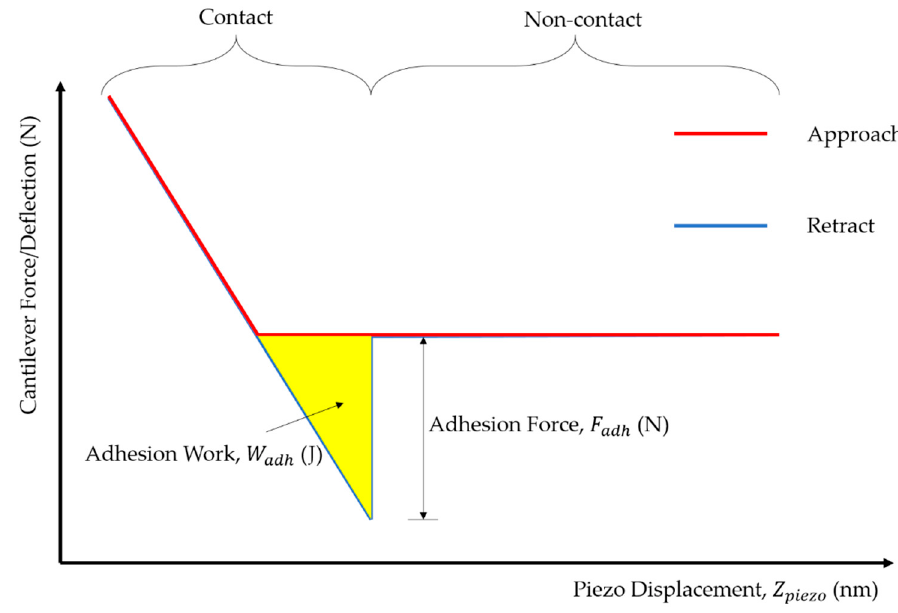
Figure 11. Typical force-displacement curve using AFM force spectroscopy.